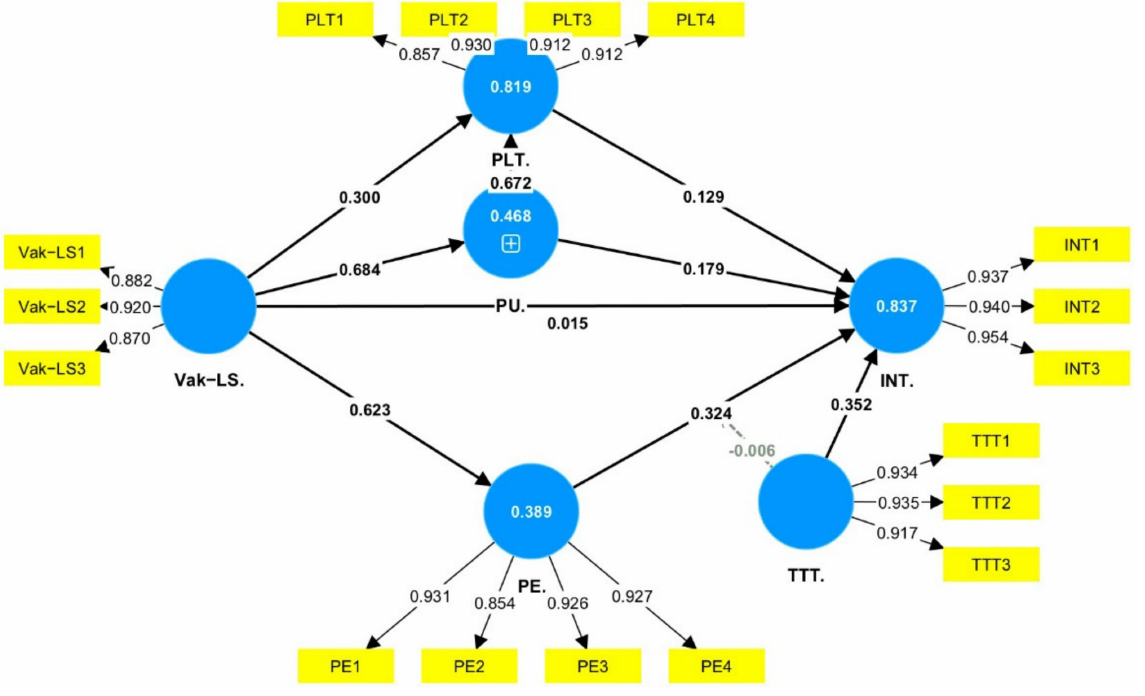
Figure 2. Graphical